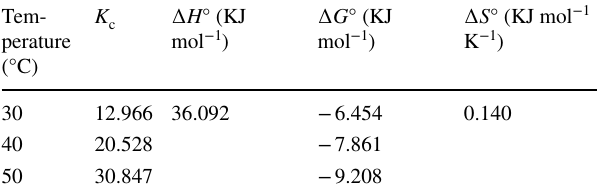
Table 4 Thermodynamic parameters for the adsorption of crystal vio- let dye on PGADP at different temperatures